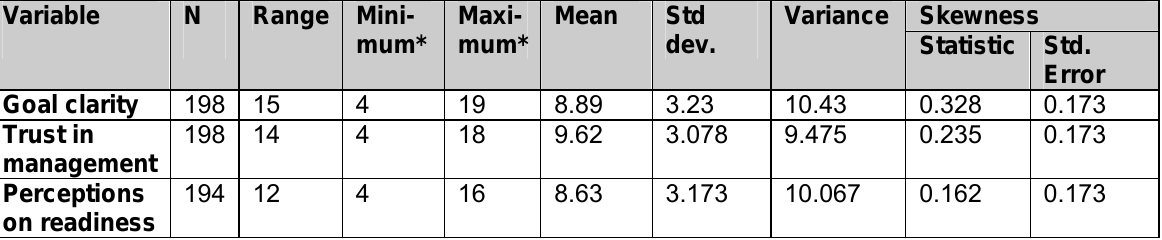
Table 4: Descriptive statistics of the three